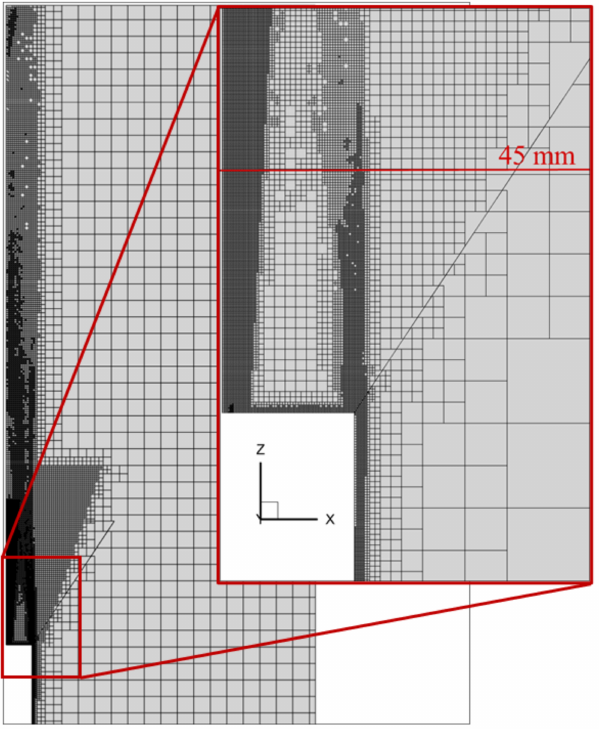
Figure 5. Example of the grid obtained after AMR